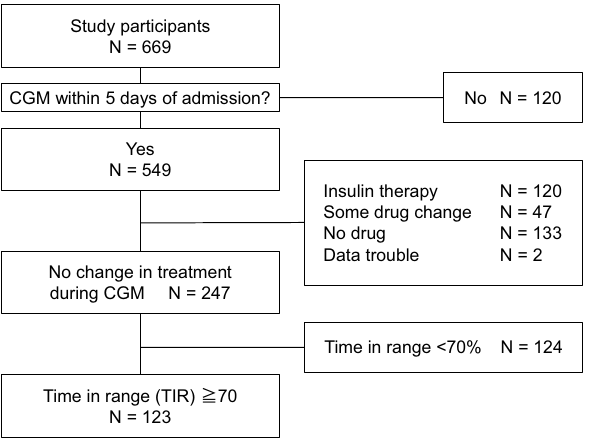
Figure 1. Flow diagram of the patient recruitment